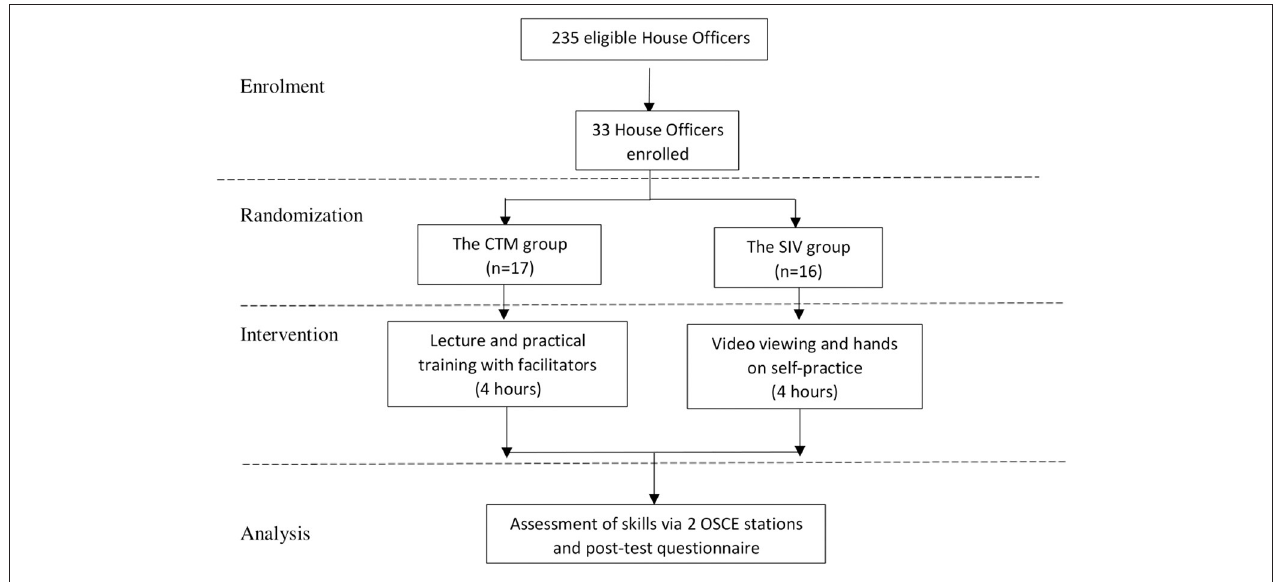
FIGURE 1 | Study flow chart according to CONSORT guidelines.